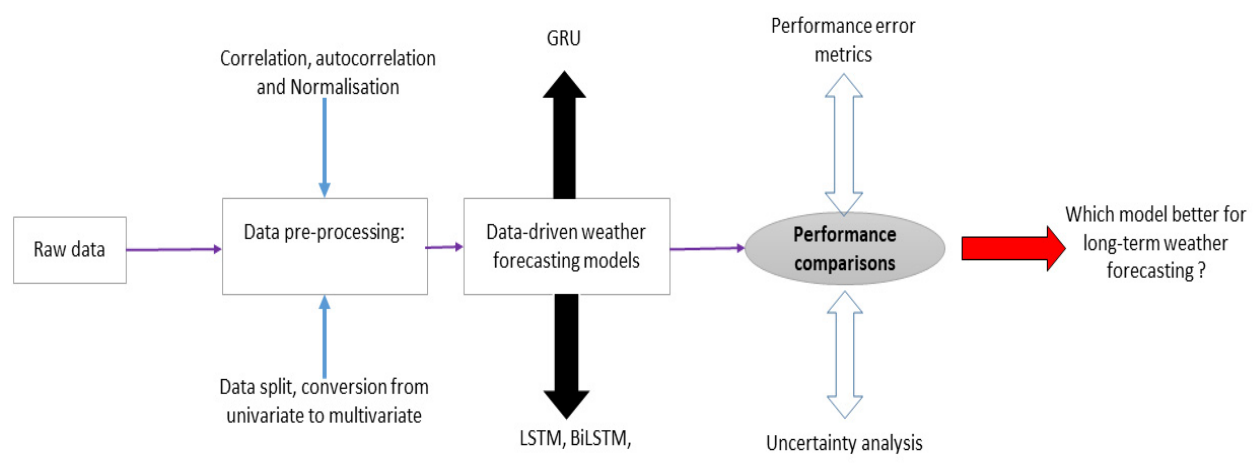
Figure 1. Framework of the proposed data-driven weather forecasting models.